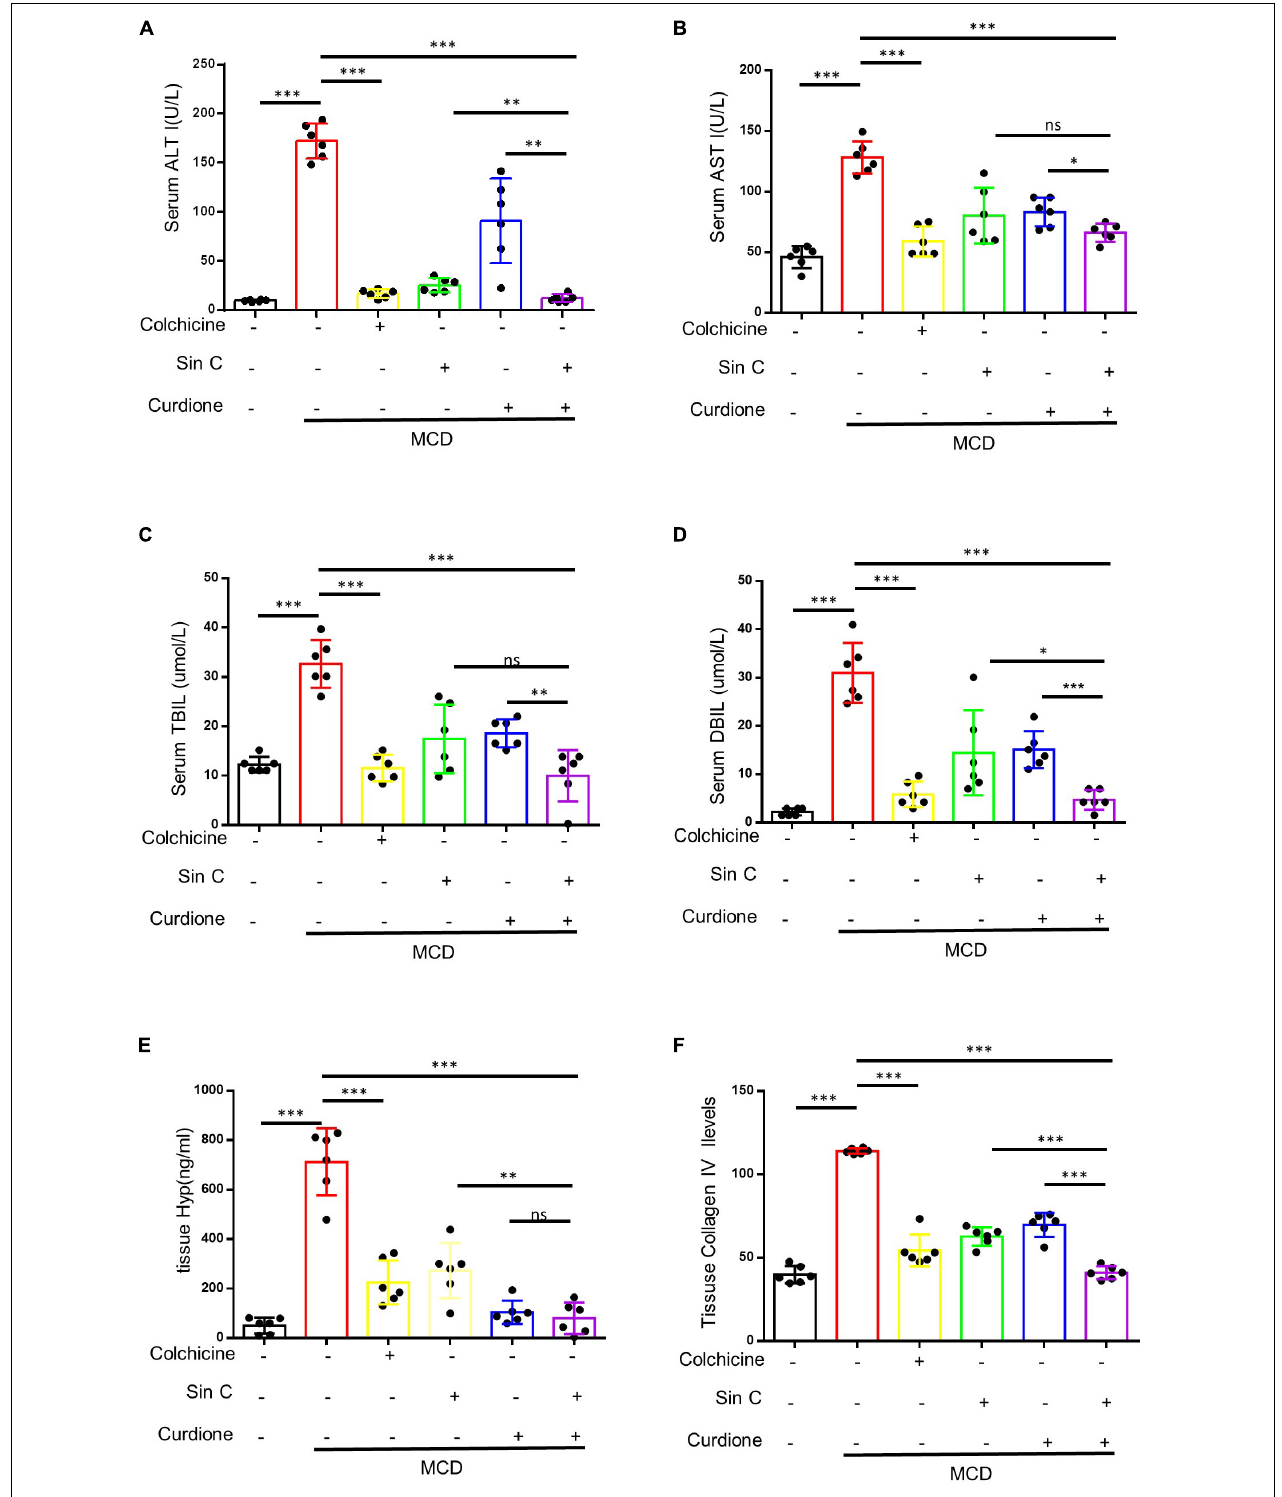
FIGURE 5 | A combination of Sin C and Curdione treatment dramatically inhibits hepatic fibrosis and injury in MCD feed fed-induced mice. Mice were treated as described in Figure 4 . Serum level of ALT (A) , AST (B) , TBIL (C) , and DBIL (D) were detected. The amount of hydroxyproline (E) and Collagen IV (F) in liver of mice were measured using commercial ELISA kits. Data are expressed as the mean ± SD from six independent mice samples, * p < 0.05, ** p < 0.01, and *** p < 0.001; ns, not significant.